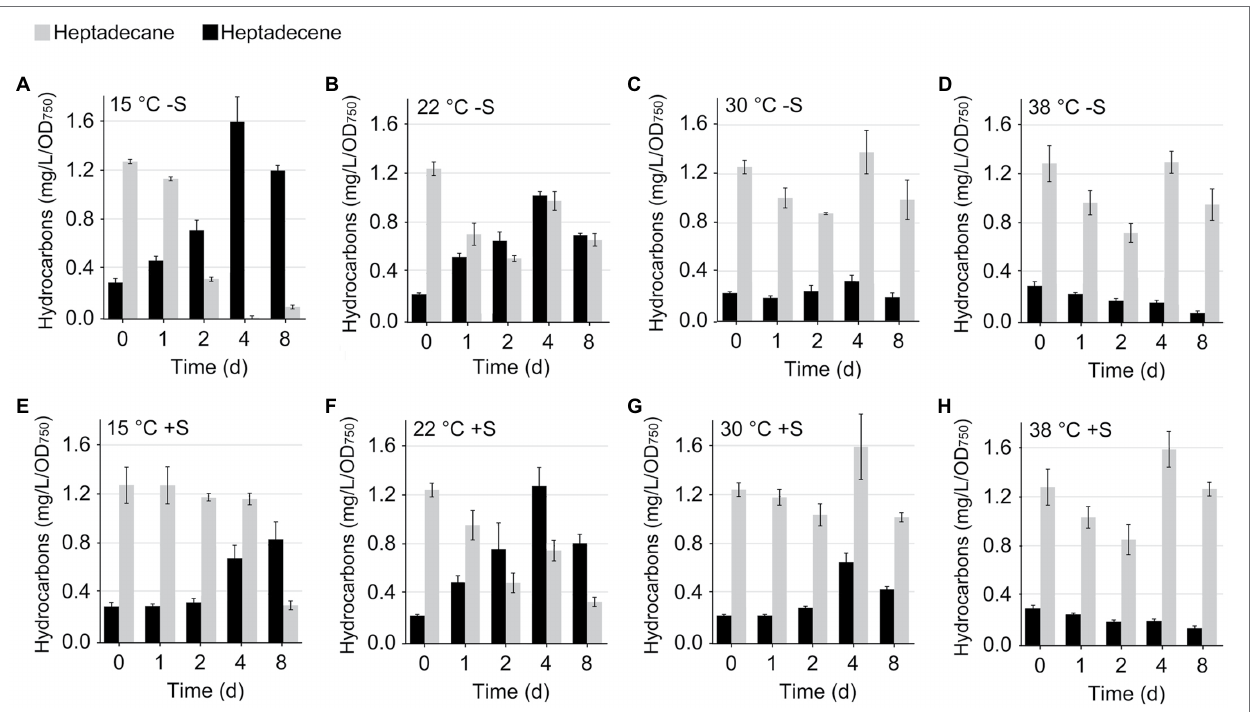
FIGURE 2 | Accumulation of intracellular heptadecene (black bars) and heptadecane (grey bars) in Synechocystis sp. PCC 6803 cells cultivated under different temperatures in standard BG-11 (-S) and in the presence of supplemented 0.5 M sorbitol (+S). The production was monitored over eight consecutive days under